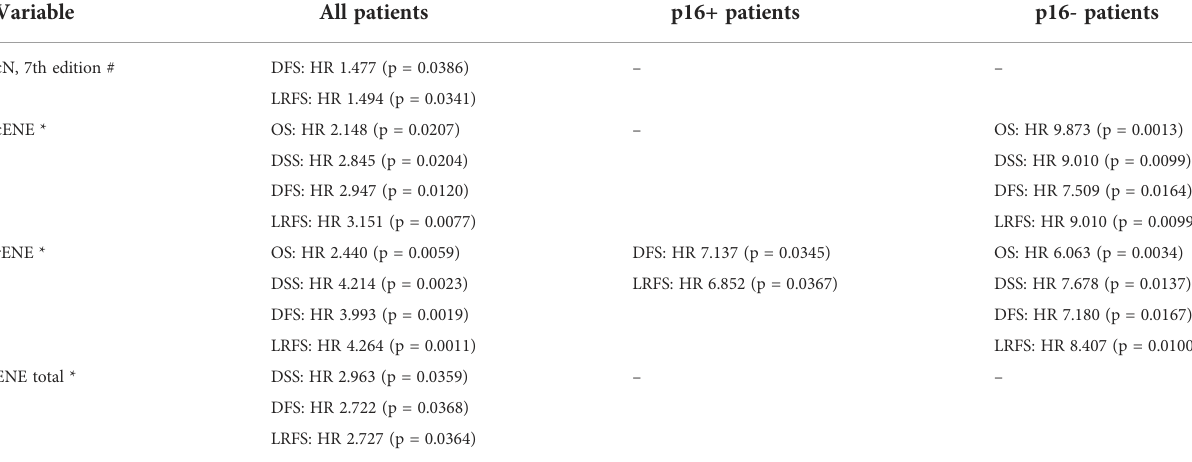
TABLE 5 Overview of signi fi cant prognosticators upon univariable analysis for various oncological outcomes. Variable All patients p16+ patients p16-